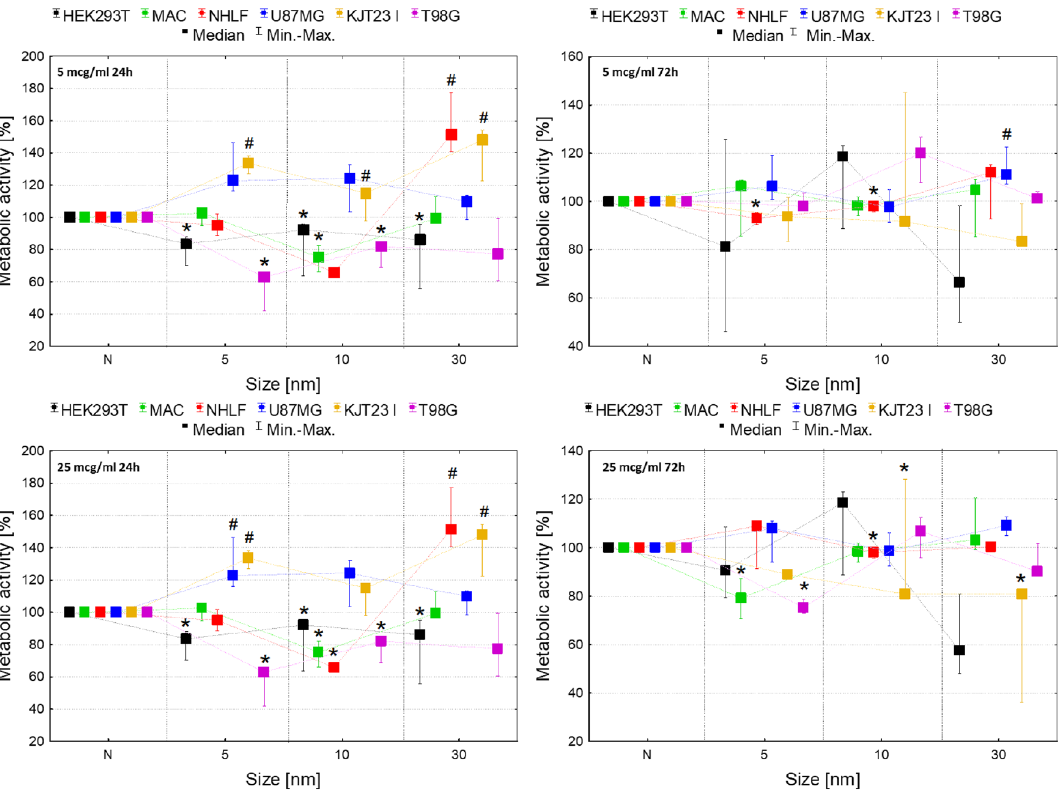
Figure 3. Normalized cell metabolic activity after 24 and 72-h exposure to IONPs with the core diameter of 5 nm, 10 nm and 30 nm in the concentrations of 5 µg Fe/ml and 25 µg Fe/ml comparing to the control groups (N). The statistically significant ( p < 0.05) increases of cell lines metabolic activity compared with corresponding N group were marked with “#” while decreases with “*”. The scales were adjusted for each chart so that data presented are the most